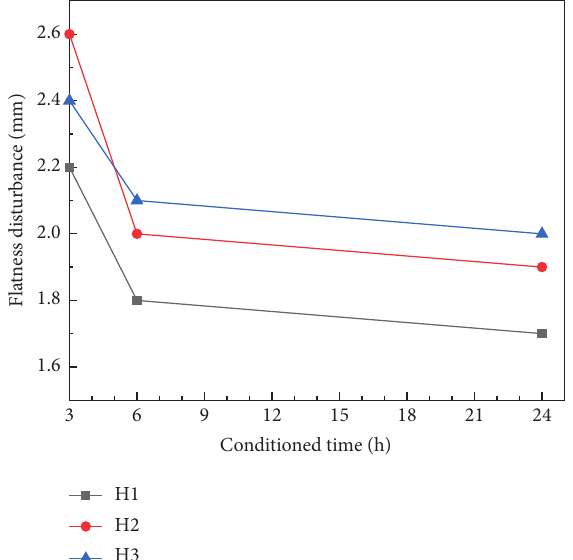
Figure 12: Variation of evenness disturbance with interval